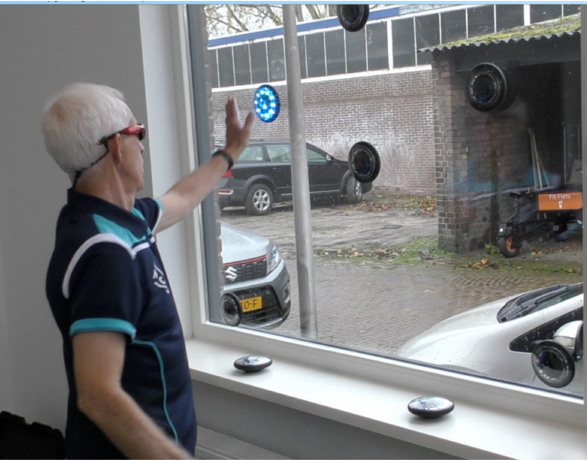
Figure 2. FitLight ® s mounted on a window for testing reaction time. The specification of the experimental set-up is in Appendix